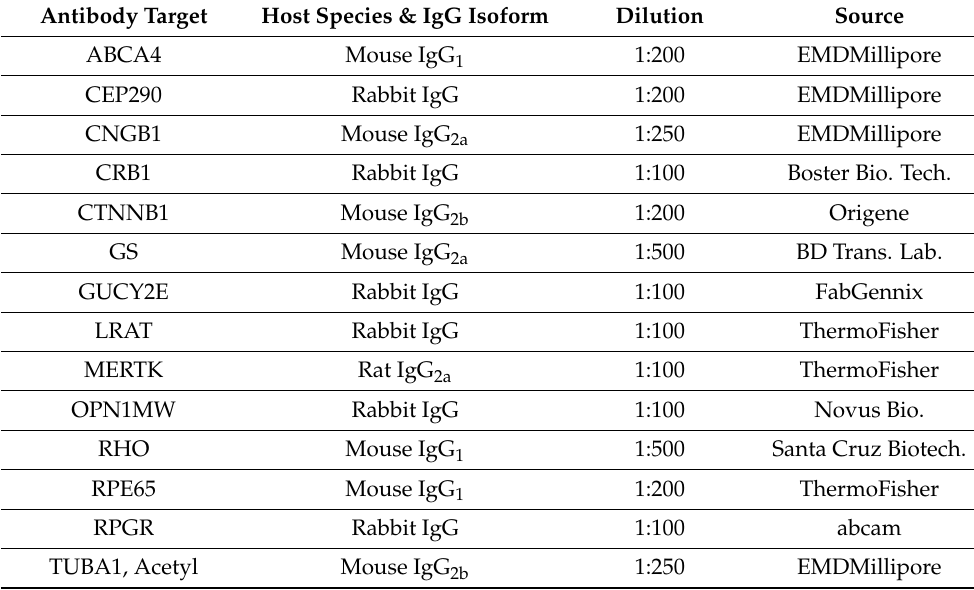
Table 1. Antibodies used for Western blots and fIHC labeling of retinal